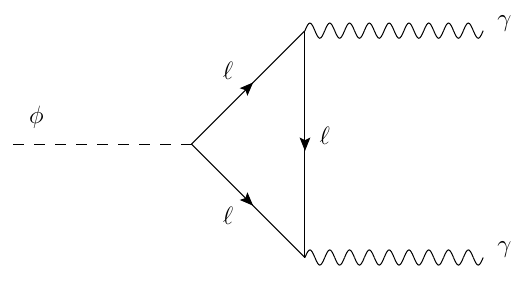
Figure 1 . Loop induced coupling of φ to a pair of